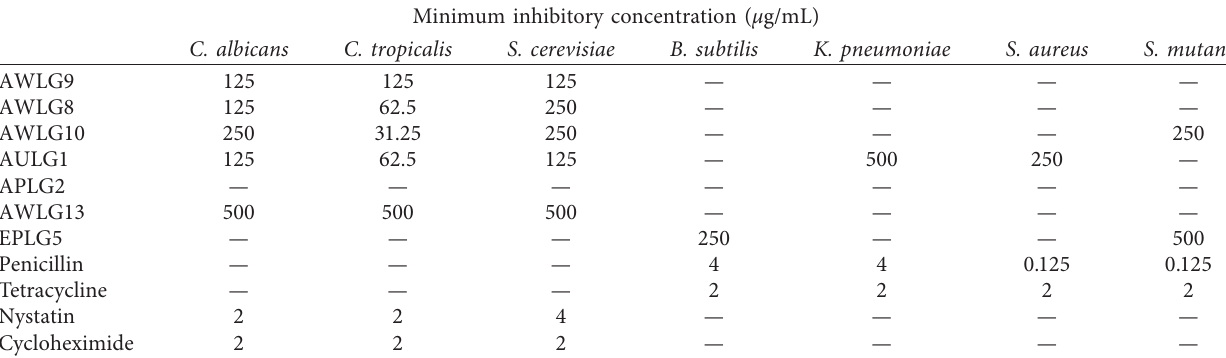
Table 4: Minimum inhibitory concentrations of the highly active isolates against the test microorganisms.